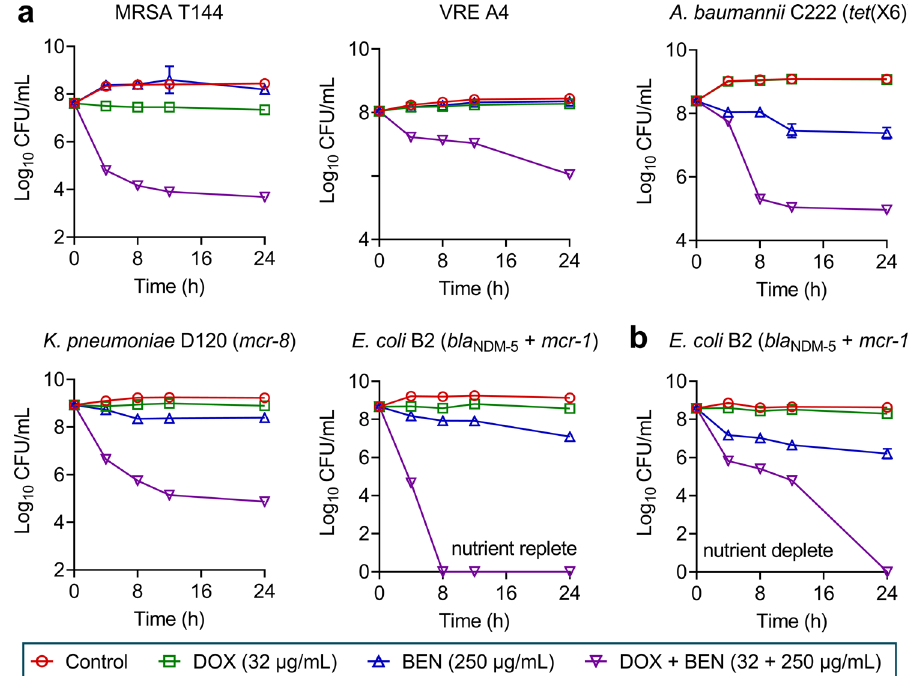
Fig. 4 Combination of doxycycline and benzydamine displays bactericidal activity against various drug-resistant bacteria. a Killing activity of doxycycline plus benzydamine in LB media against MDR Gram-positive bacteria (MRSA T144 and VRE A4) and Gram-negative bacteria ( A. baumannii C222, K. pneumoniae D120, and E. coli B2). b Time-killing curves of doxycycline, benzydamine alone, or their combination in PBS against E. coli B2. The initial cell density is about 10 8 CFU/mL. All data were performed from three biological replicates and shown as mean ±